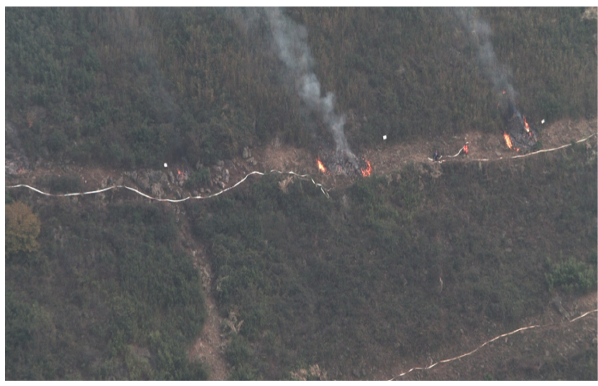
Figure 15. Detection result using STPM.